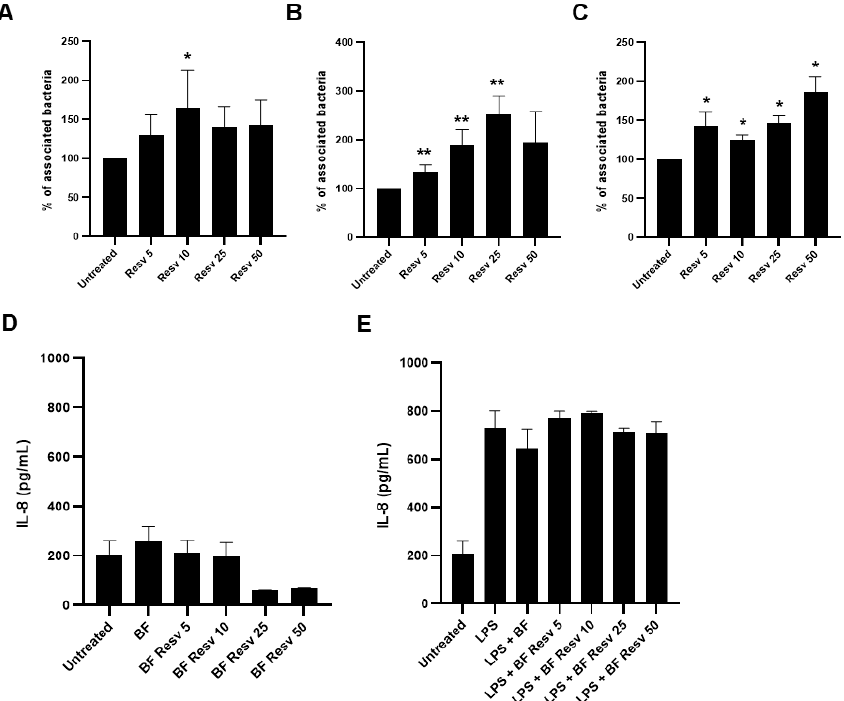
Figure 3. Resveratrol increased adhesion of L. paracasei ATCC334 to human intestinal epithelial cells (IECs) without eliciting an exacerbated pro-inflammatory response. ( A ) Adhesion of L. paracasei to HCT116 or ( B ) HT-29 IECs untreated or pre-treated for 1 h 30 min with increasing doses of Resveratrol, from 5 µM (Resv 5) to 50 µM (Resv 50). Adherent cells were enumerated on MRS agar plates and results are expressed as mean percentage ± SEM of associated bacteria of at least three independent experiments, taken untreated bacteria value as 100%. * p < 0.05, ** p < 0.01 ( versus untreated). ( C ) Adhesion to HT-29 IECs of 24 h biofilm grown L. paracasei , in the absence (untreated) or presence of increasing doses of Resveratrol, from 5 µM (Resv 5) to 50 µM (Resv 50). Results are expressed as in A and B panels. ( D ) HT-29 IECs were untreated or treated with biofilm-grown living L. paracasei at a MOI of 40 for 4 h. L. paracasei were grown under biofilm conditions in the absence (BF) or presence of increasing doses of Resveratrol, from 5 µM (BF Resv 5) to 50 µM (BF Resv 50). IL-8